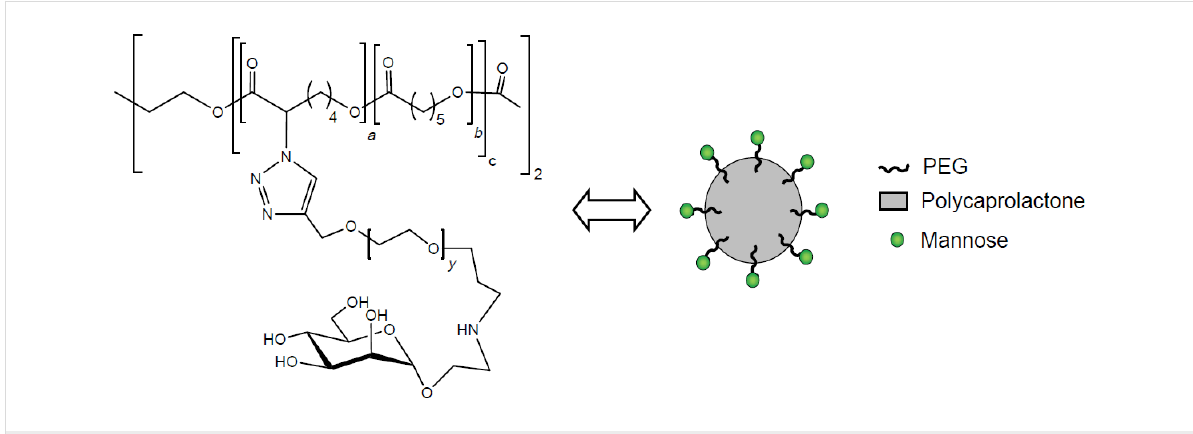
Figure 4: PEGylated mannose derivatives, adapted from [45].